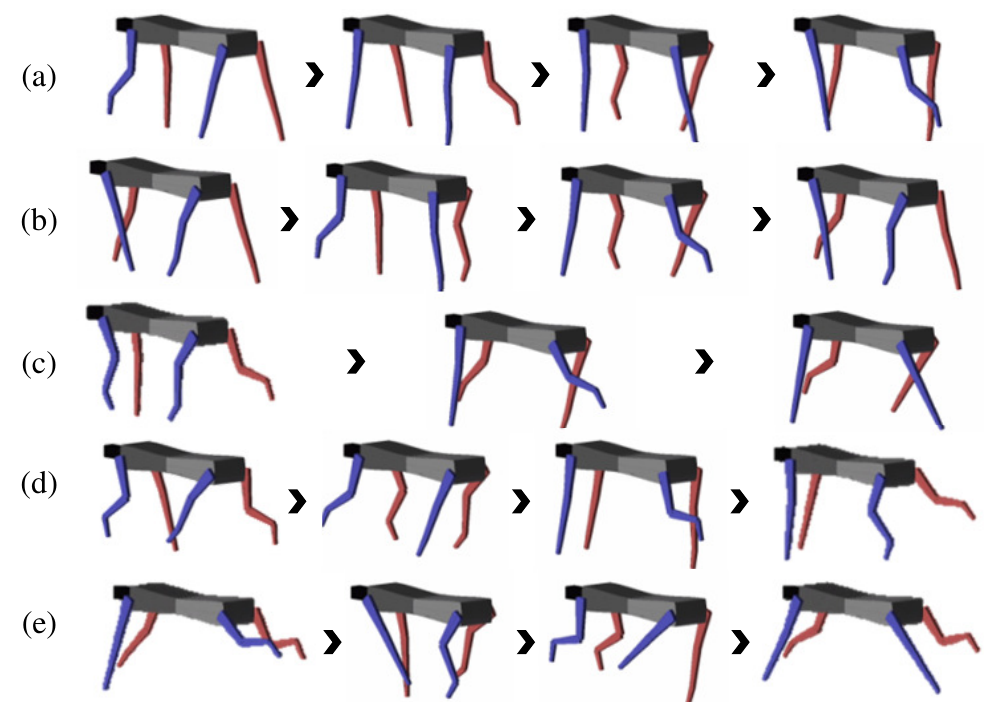
Figure 20. The leg motions of multiple gait phases from the proposed algorithm simulation: ( a ) the walk phase, ( b ) the trot phase, ( c ) the canter phase, ( d ) the transverse gallop phase, and ( e ) the rotatory gallop